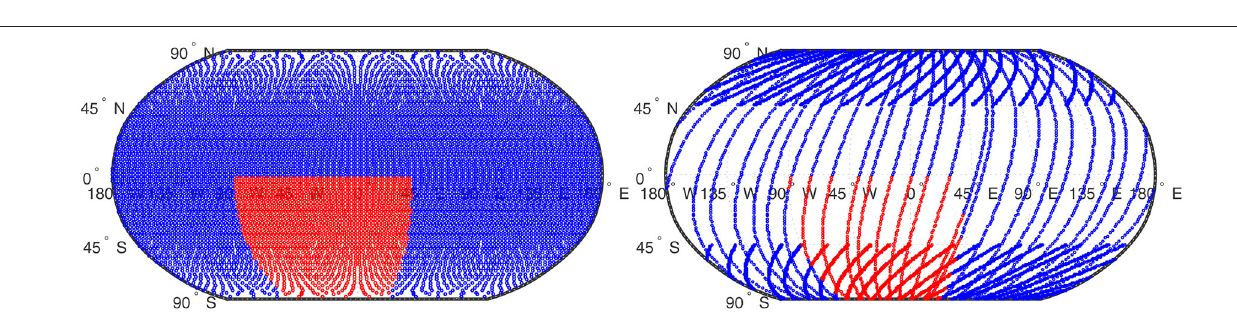
FIGURE 2 | The track sets of the scattered grid (Left, Right) . For the South pole, we have an analogous point distribution.